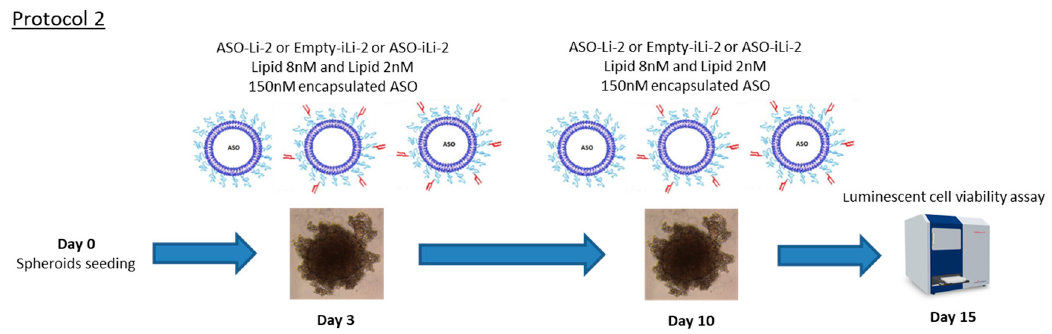
Figure 7. Protocol 2: liposomal antiproliferative activity with long exposition time. 3D in vitro assessment with spheroid treatment protocol 2. All the measures were performed in triplicate. Empty liposomes and immunoliposomes showed no in vitro cytotoxicity (data not shown). Results of cytotoxic studies with protocol 1 are summarized in Figure 8. Greater cytotoxicity was observed in PCa exposed to liposomes with both treatment schemes. No e ff ect was detected with ASO-iLi-2 at 8 nM with both